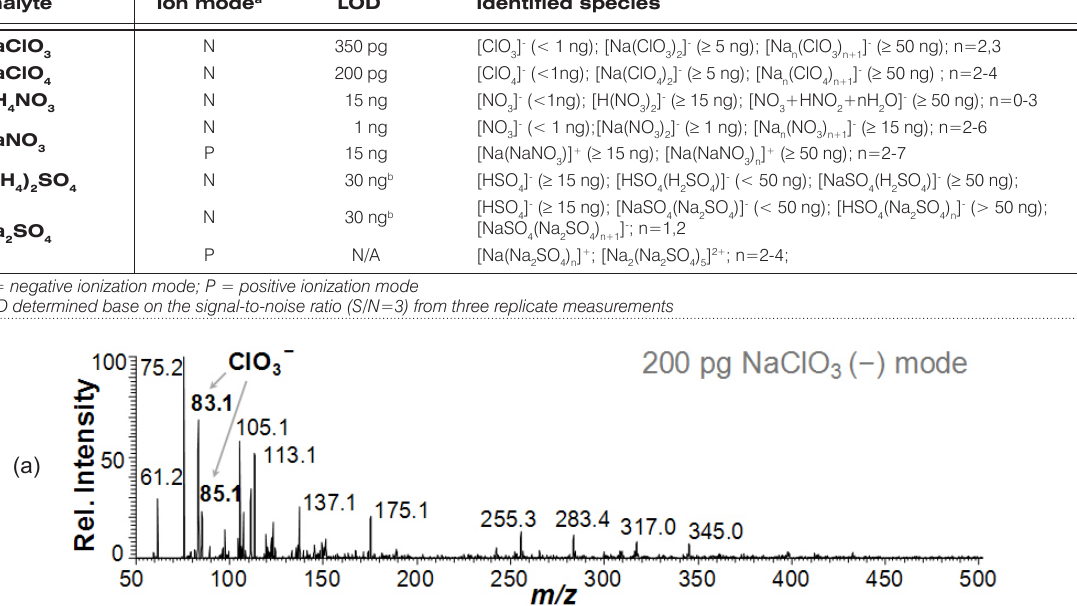
Table 1. Summary of DESI MS detection of inorganic salts from nonporous PTFE surface Analyte